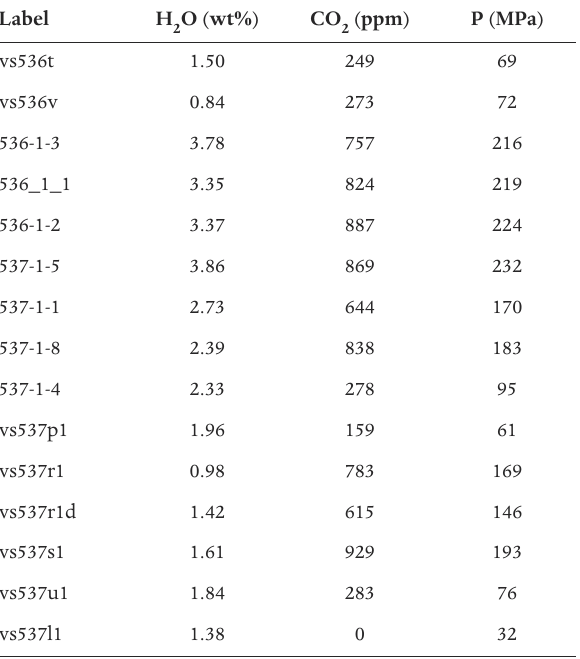
O and CO concentrations in melt inclusions by FTIR Table 4. H 2 2 analyses after correction for post entrapment crystallization. P (MPa) was derived from the model of Papale et al. [2006].